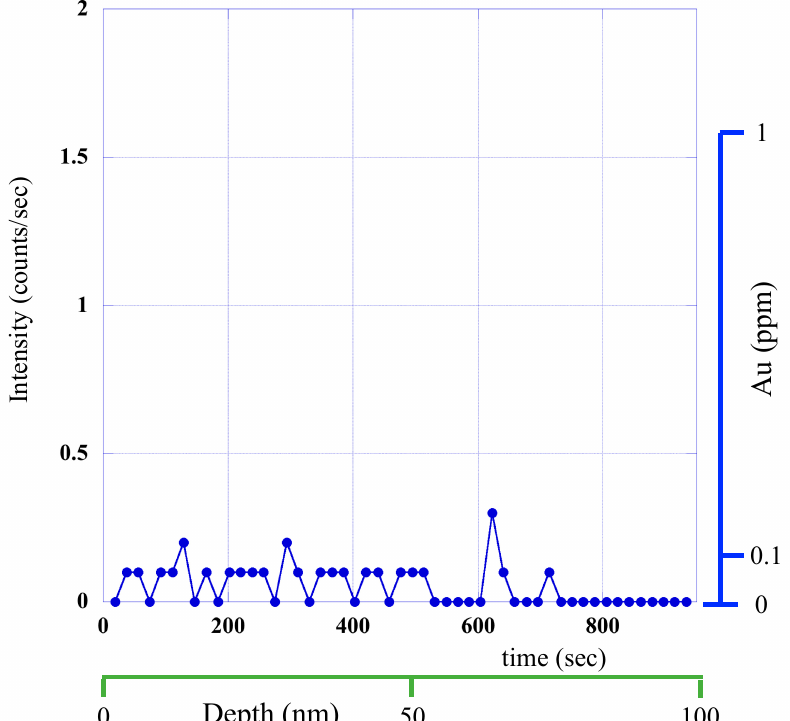
Figure A3. Depth profile of Au concentration vs. depth in pyrite (Au1*47.adp in Table A1) from the Kalahari Goldridge deposit. No peaks corresponding to Au NPs are present in the profile. The Au concentration is very low and includes EM (electron multiplier) background noise.